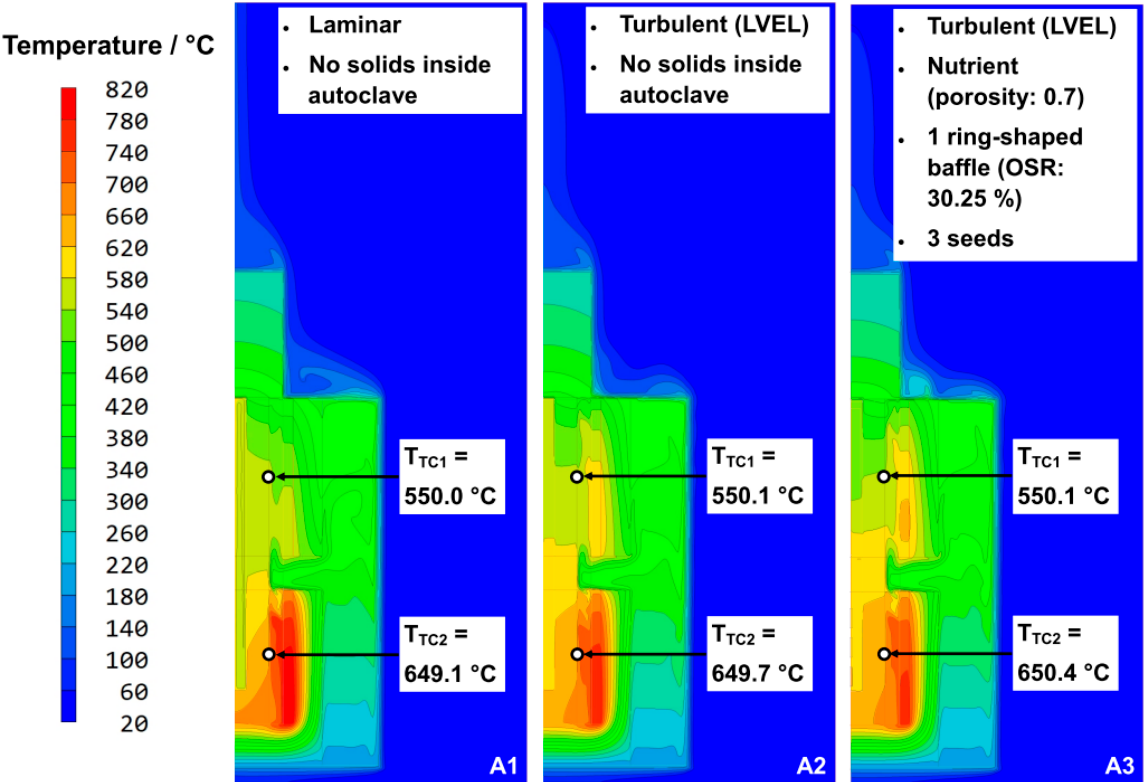
Figure 7. Overview of temperature distribution in the entire domain for cases A1, A2, and A3, respectively. A brief description of the characteristics of each case is given in the insets at the top.